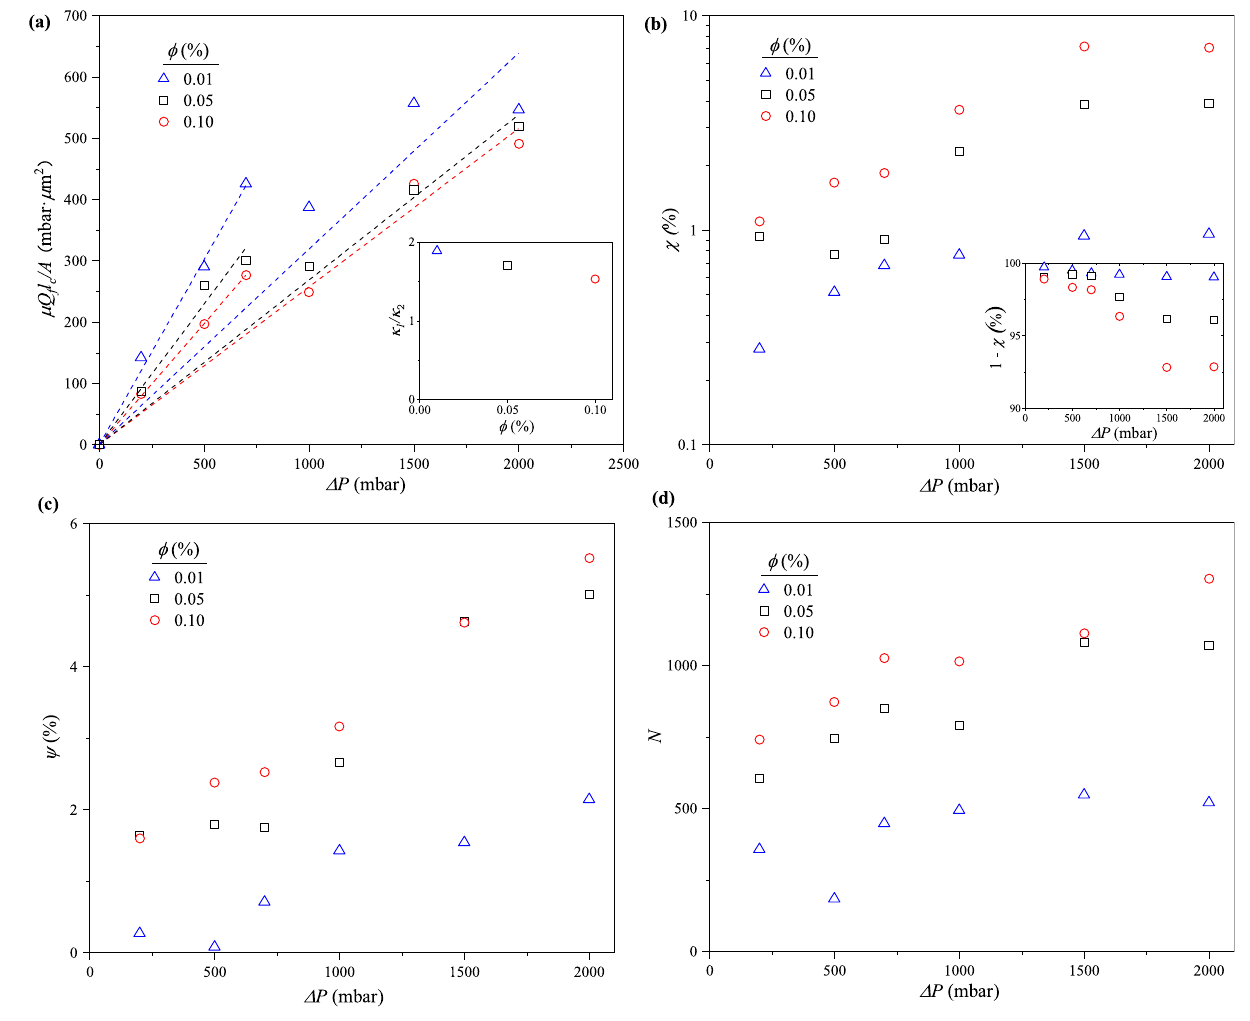
Figure 5. The presence of two (cid:31) P regions (one below and above (cid:31) P = 1000 mbar), indicating significant differences in particle packing in the channels after “full clogging” is established. This is illustrated by ( a ) Device permeability ( κ ) estimated by fitting the final flowrate ( Q f ) to Darcy’s Law. Inset: the ratio of κ for � P < 1000 mbar region to (cid:31) P ≥ 1000 mbar ( κ 1 /κ 2 ) slightly decreased as φ was increased. ( b ) Percentage of device volume occupied by particles ( χ ). Inset: percentage of voids in the clogged device (porosity). ( c ) Coverage ( ψ ) is the percentage of the total channel area filled with clogs. ( d ) Number of clogging events ( N ). In all cases of (cid:31) P and φ , N is greater than the total number of